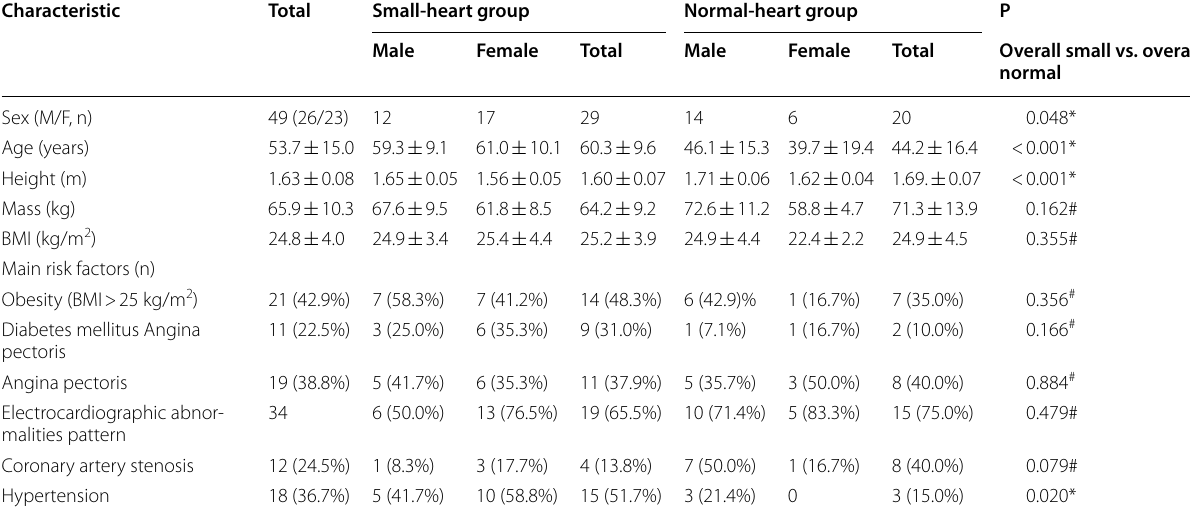
Table 2 Characteristics of